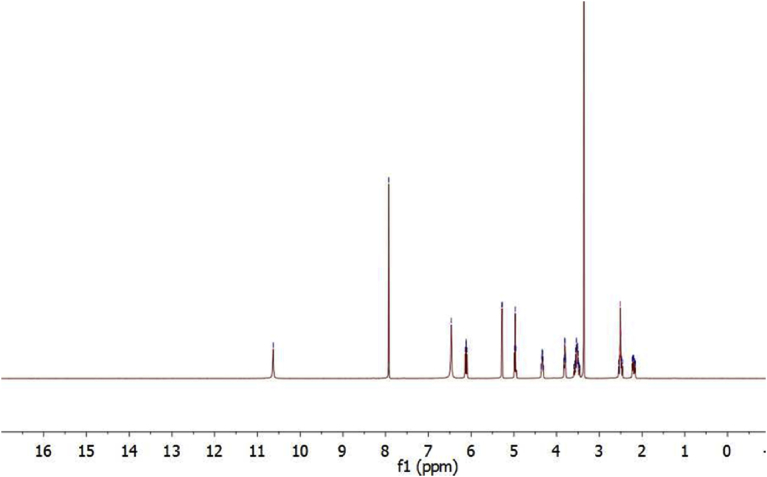
1H NMR of guanosine in DMSO.